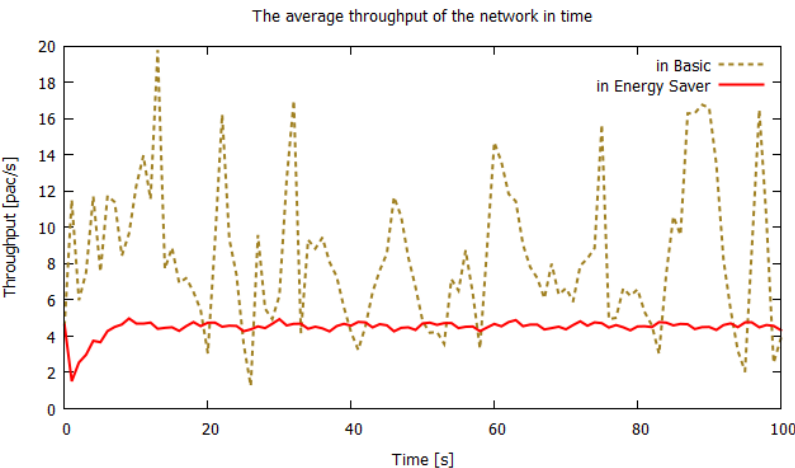
Figure 10. Average throughput per link in the network as a function of time for basic and energy- saving